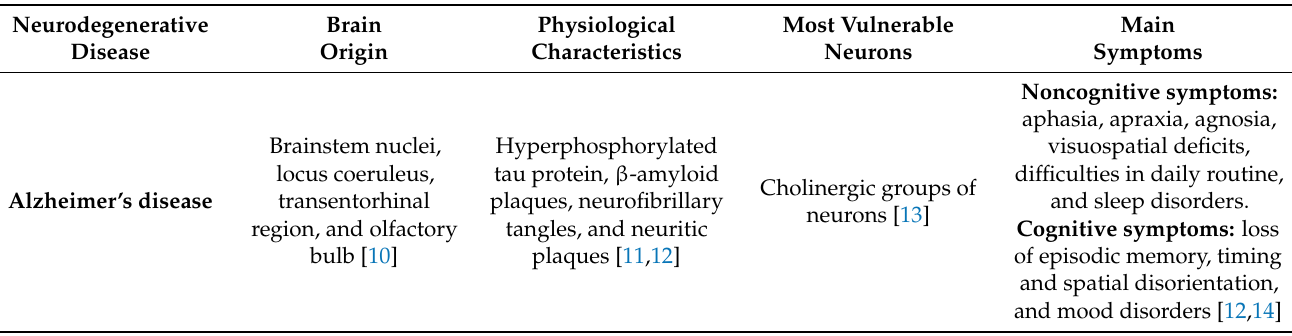
Table 1. Main features of the most prevalent neurodegenerative